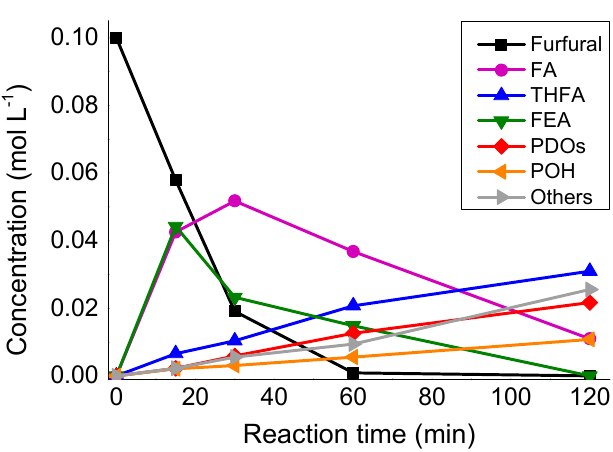
Figure 6. Furfural hydrogenation with Pt / Nb 2 O 5 .